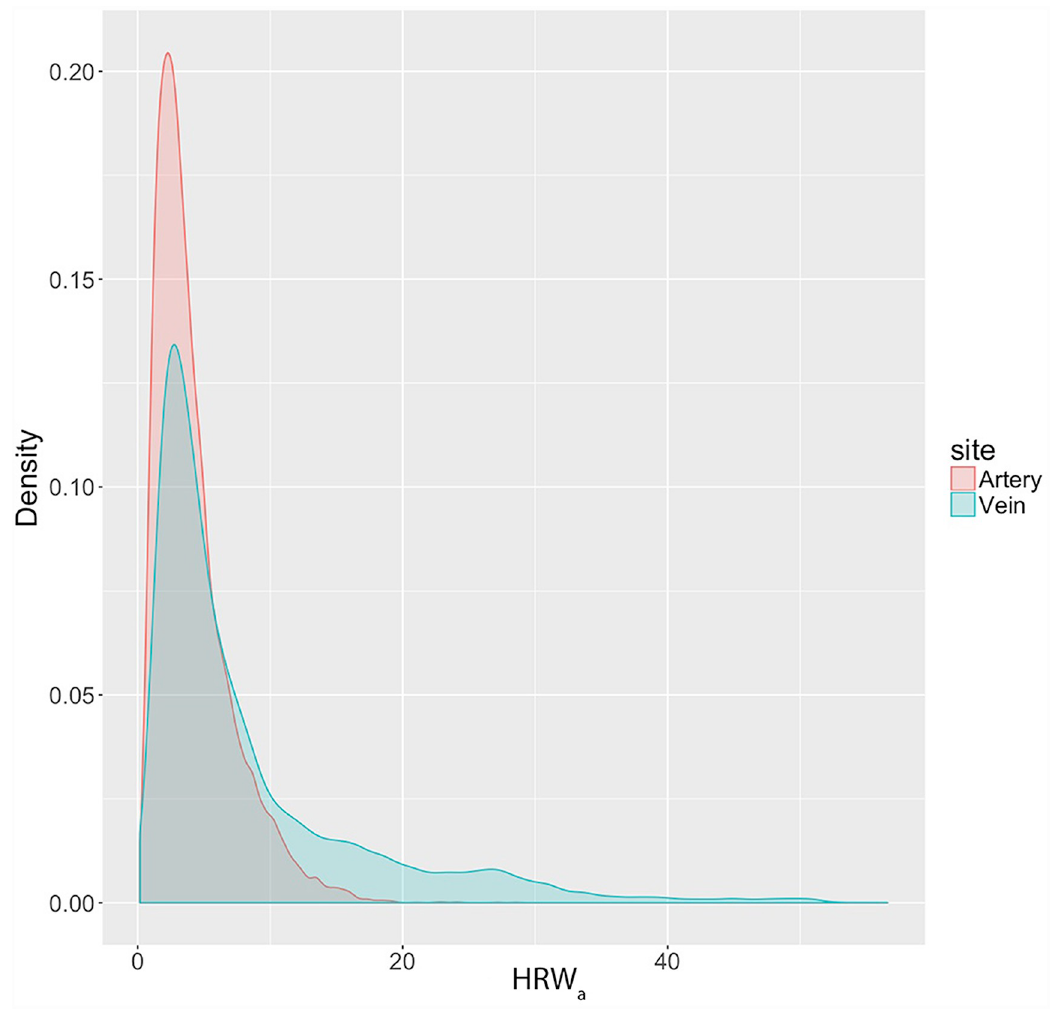
Fig 4. Density plot of the harmonic regression wave amplitude (HRW a ) distribution in the retinal vascular system. The distribution of the HRW a is non-normal, demonstrating a right skew in both retinal vascular systems. A larger skew in the HRW a distribution is demonstrated from values from the retinal veins compared to the retinal